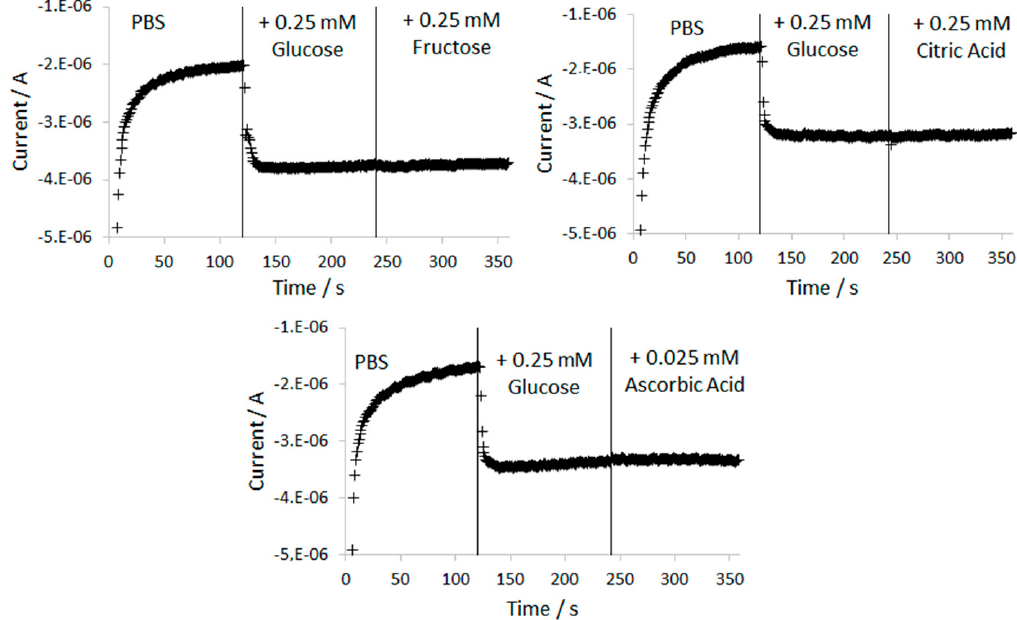
Figure 5. Amperometric responses of the Chitosan–GOx/TiO 2 NTAs/Ti biosensor measured in 0.1 M PBS pH 7.0 at potential of − 0.4 V vs. Ag/AgCl with the addition of 0.25 mM glucose and 0.25 mM fructose ( A ); 0.25 mM citric acid ( B ) and 0.025 mM ascorbic acid ( C ) respectively.